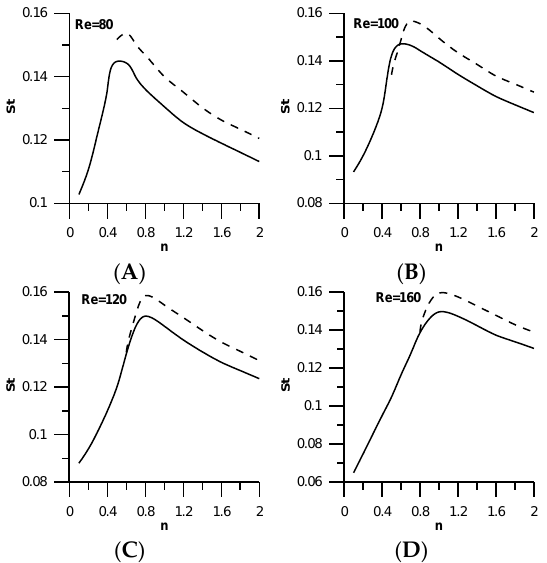
Figure 7. Values of Strouhal number for different Reynolds numbers for shear-thinning and shear- thickening fluids: ( A ) Re = 80; ( B ) Re = 100; ( C ) Re = 120; ( D ) Re = 160. The solid line represents the present work with H/D = 50,000; the broken line represents the work of Sahu et al. [8] with H/D = 20.